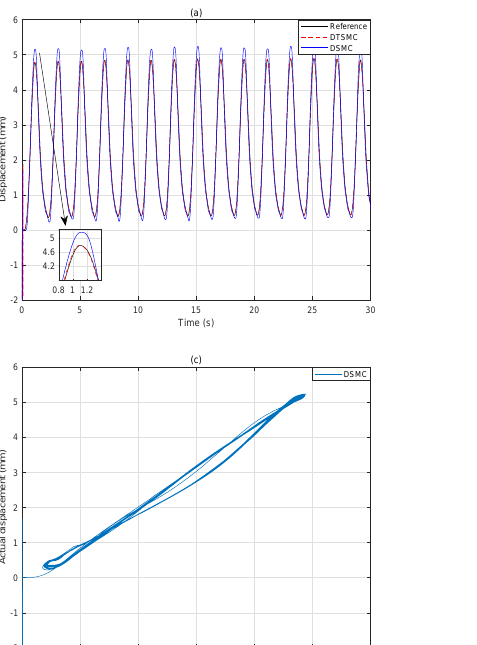
Figure 13. The tracking results under 0.4 Hz input signal. ( a ) Displacement output. ( b ) Tracking error. ( c ) Desired displacement versus actual displacement of the DSMC. ( d ) Desired displacement versus actual displacement of the DTSMC.